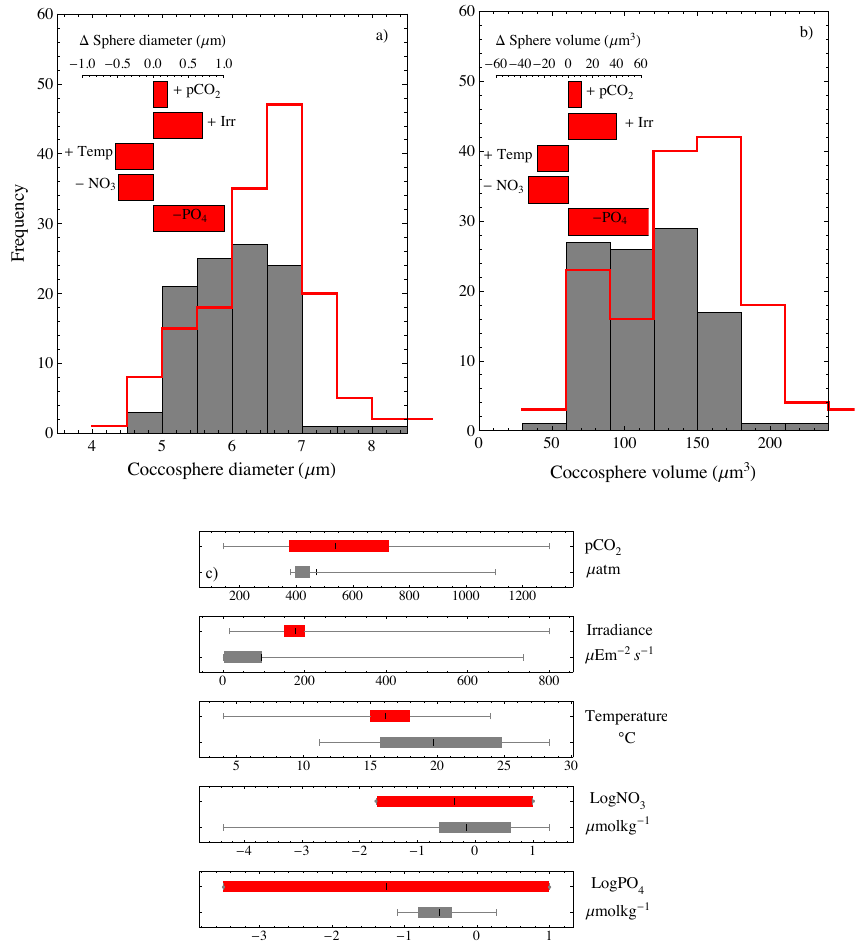
Figure 8. Comparison of the geometry (coccosphere diameter and volume) of Isochrysidales coccospheres from the BIOSOPE transect with the geometry of E. huxleyi coccospheres from laboratory culture experiments. Histograms in panels (a) and (b) compare BIOSOPE field data (grey) with experimental data (red). Horizontal bar graphs in panels (a) and (b) show the average changes in coccosphere geometry observed in E. huxleyi culture experiments for given changes in p CO 2 , irradiance, temperature, NO 3 and PO 4 . (c) Box-and-whisker plots comparing environmental conditions at the BIOSOPE stations where Isochrysidales coccosphere geometry measurements were made (grey) with the range of environmental conditions imposed in laboratory culture experiments with E. huxleyi (red). Box-and-whisker plots show the minimum value, lower quartile, median, upper quartile and maximum value of a given environmental parameter. Note: size data for Fe limitation is from one experiment in Schultz et al. (2007) and refers to cell size (not coccosphere